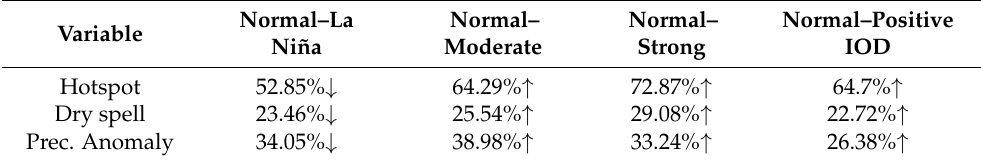
Table 7. Kalimantan—difference value of the PDF from years categories.